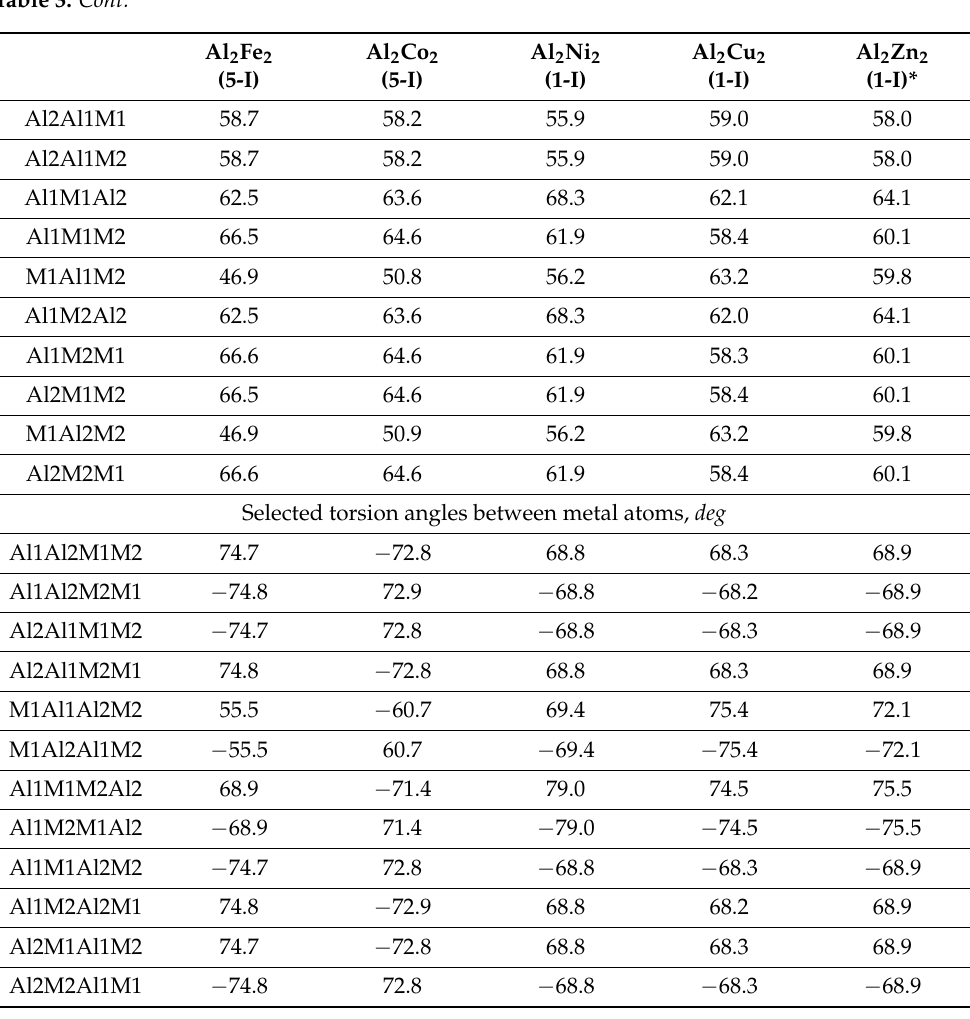
( j ) Figure 1. The images of most stable Al 2 M 2 metal clusters: ( a )—Al 2 Sc 2 (3-I), ( b )—Al 2 Ti 2 (3-I), ( c )—Al 2 V 2 (3-I), ( d )—Al 2 Cr 2 (1- I)*, ( e )—Al 2 Mn 2 (1-I)*, ( f )—Al 2 Fe 2 (5-I), ( g )—Al 2 Co 2 (5-I), ( h )—Al 2 Ni 2 (1-I), ( i )—Al 2 Cu 2 (1-I), ( j )—Al 2 Zn 2 (1-I)*. The images of higher occupied and low unoccupied (vacant) molecular orbitals (HOMO and LUMO, respectively) for the metal clusters under consideration are presented in Figures 2 and 3, while the pattern of distribution of the spin density in these metal clusters is given in Figure 4.